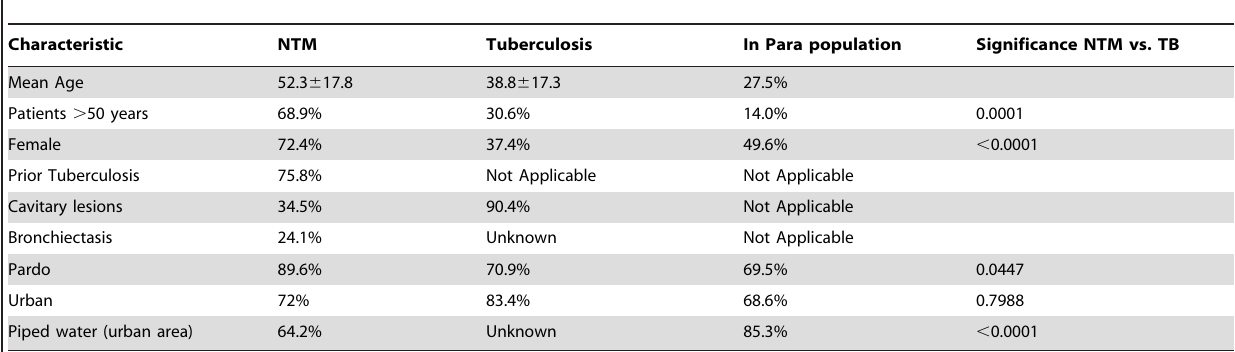
Table 4. Summary of distinguishing features of NTM